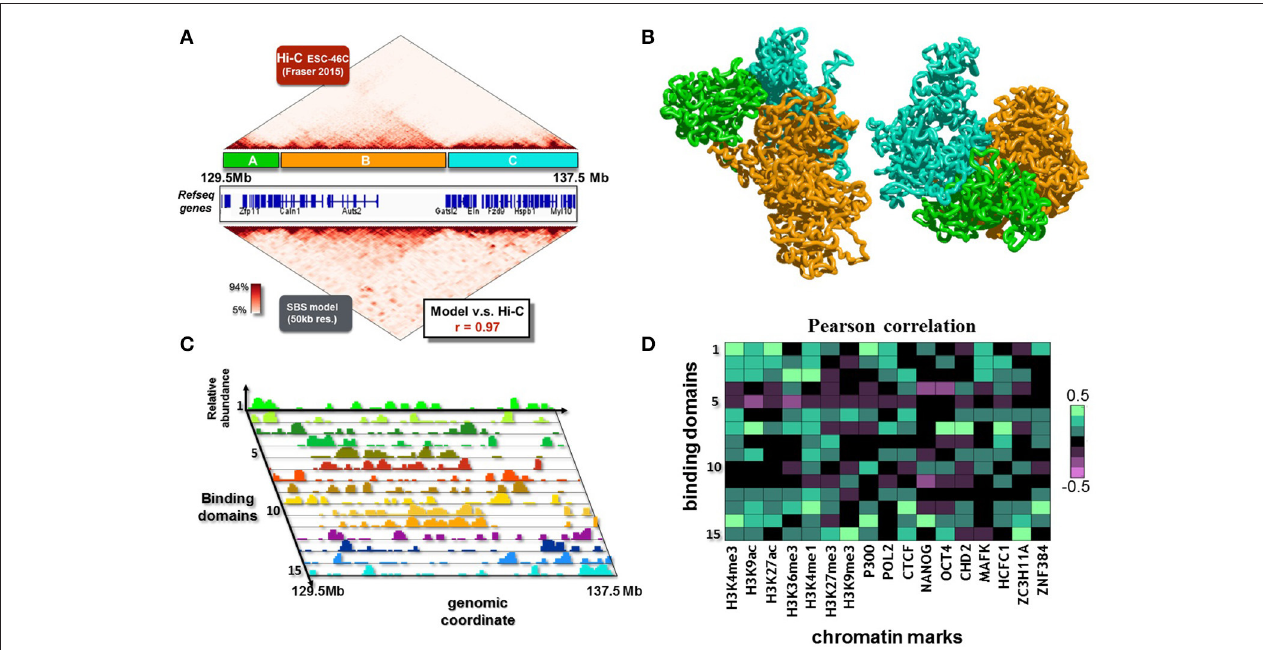
FIGURE 5 | The 3D structure of the 7q11.23 locus in ESC-46C cells. (A) The modeled 8Mb region (chr5:129500000-137500000, mouse ESC-46C cells) is shown. This region is syntenic with the 7q11.23 locus in human genome, which is linked to a variety of neurological disorders, such as autism or the Williams-Beuren syndrome. The Hi-C experimental data (binned at 50Kb resolution, from ( Fraser et al., 2015), top matrix) are reproduced by the contact matrix inferred from the SBS model (bottom matrix) with good accuracy (Pearson correlation coefficient r = 0.97). (B) Two independent 3D reconstructions derived by Molecular Dynamics simulations. The major contact domains of the locus have complex, long range interactions with each other (e.g., the contacts between the green and cyan domains), in agreement with the Hi-C data. (C) The SBS inferred binding domains of the locus, which drive its folding, are here shown. On the z-axis, their relative abundance (each binding domain is represented with a different color, on the y-axis) is shown as a function of the genomic coordinate (x-axis). (D) Pearson correlation coefficients between the relative abundance of binding domains with epigenetic chromatin